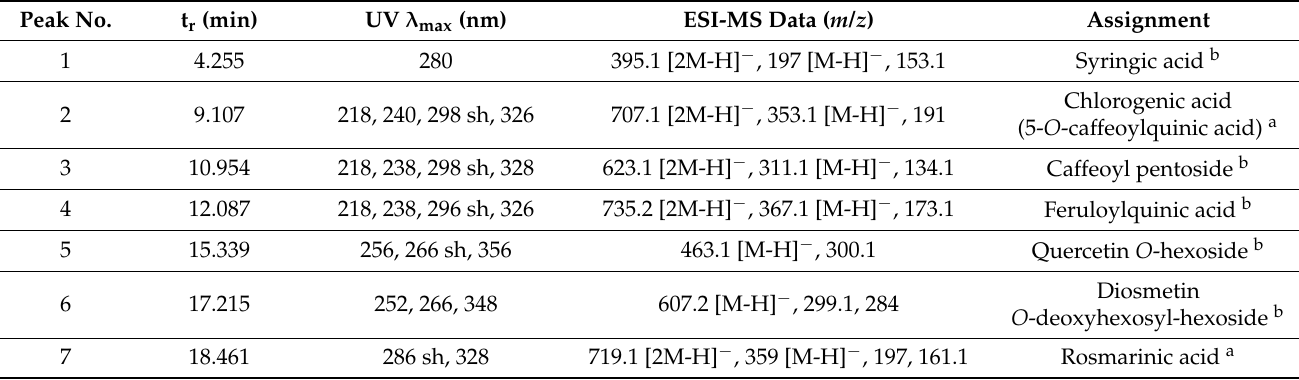
Table 3. Assignment, retention times, UV and MS spectral data of phenolic compounds in methanol extracts of Hyssopus officinalis subsp. aristatus . a Identification by comparing with commercial reference compounds. b Tentative identification by comparing acquired UV and MS spectral data with literature data.